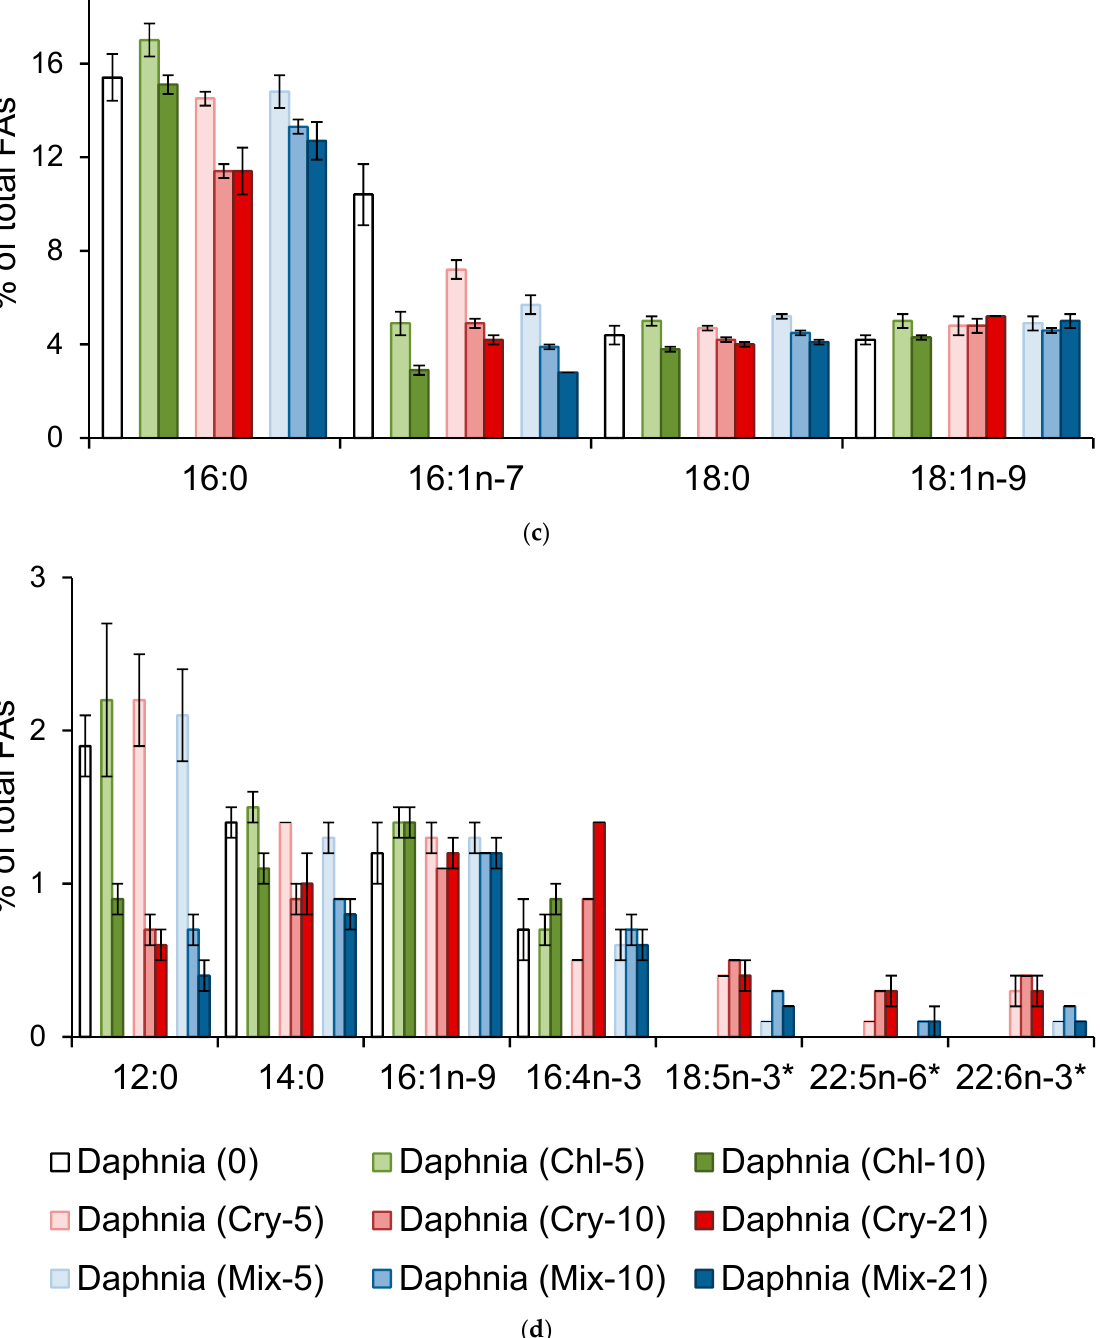
Figure 3. Mean values (% of the total FAs ± SE) of FAs in Daphnia fed Chlorella (Chl), Cryptomonas (Cry), and their mixture (Mix) at Days 5, 10, and 21 of the experiment, and in the stock culture (0). ( a ) FAs that were higher in Chlorella ; ( b ) FAs that were higher in Cryptomonas ; ( c ) dominant saturated and monounsaturated FAs; ( d ) minor FAs. Horizontal bars represent standard errors. Non-normally distributed variables are marked with *.